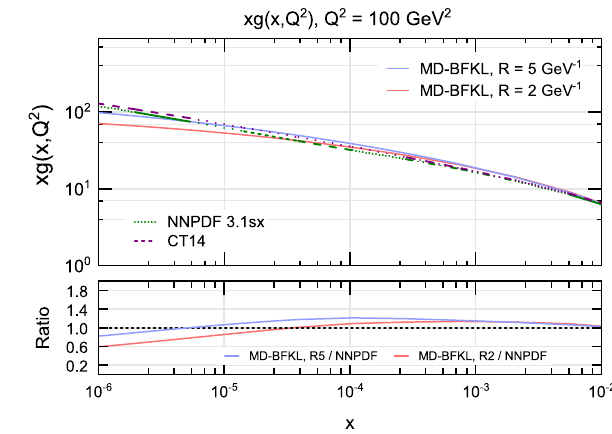
Fig. 7 x evolution of collinear gluon distribution xg ( x , k 2 results of KC improved MD-BFKL are shown for conventional R = 5 GeV − 1 (gluons are distributed throughout the nucleus) and R =